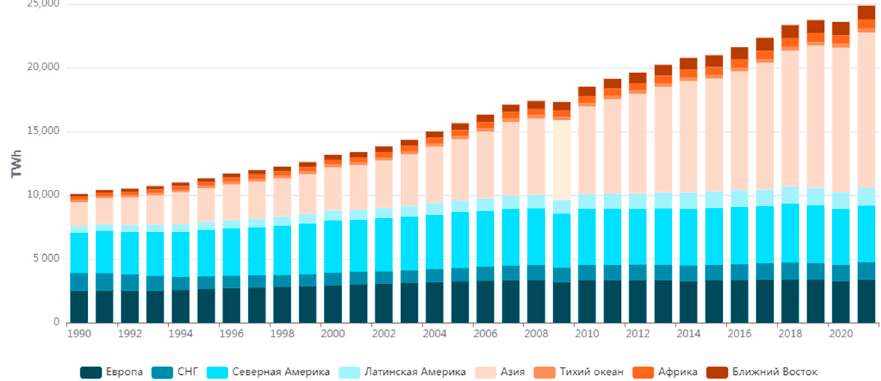
Figure 1. World Electricity Consumption for 1990–2021.